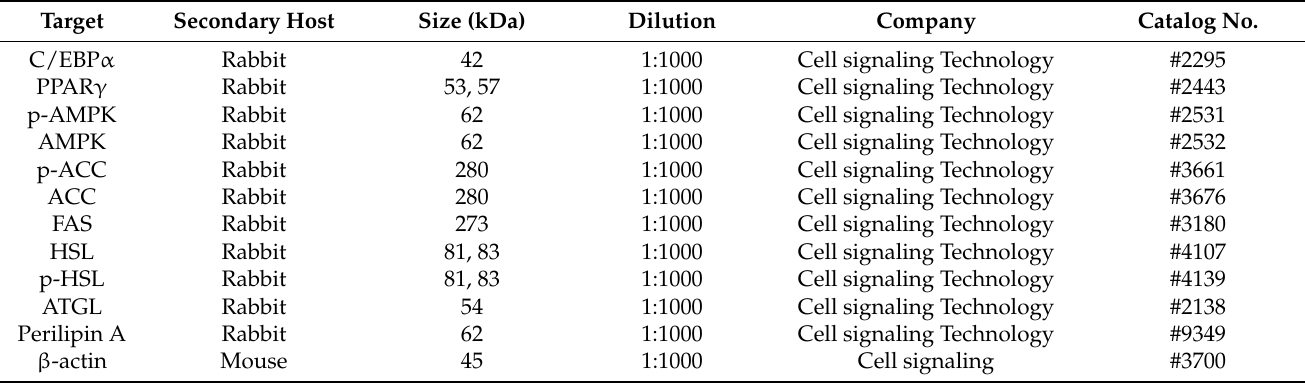
Table 2. The primary antibodies used for Western blot